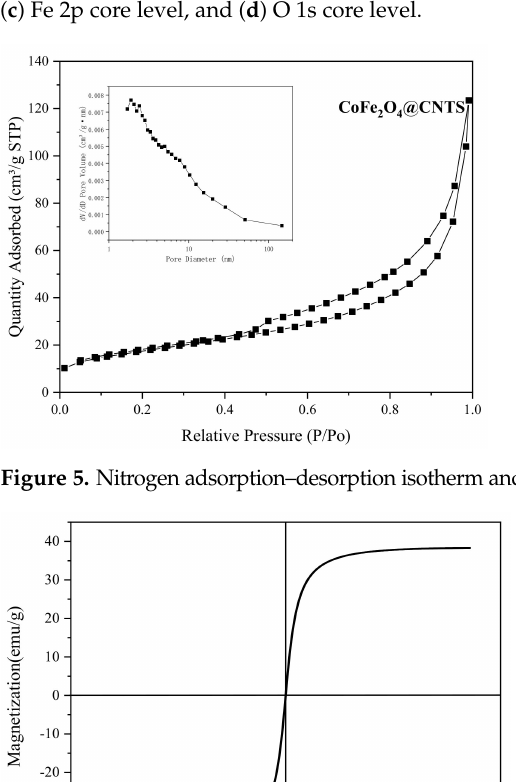
Figure 4. Fresh CoFe 2 O 4 @CNTs XPS spectra: ( a ) full-range scan of the samples, ( b ) Co 2p core level, ( c ) Fe 2p core level, and ( d ) O 1s core level.